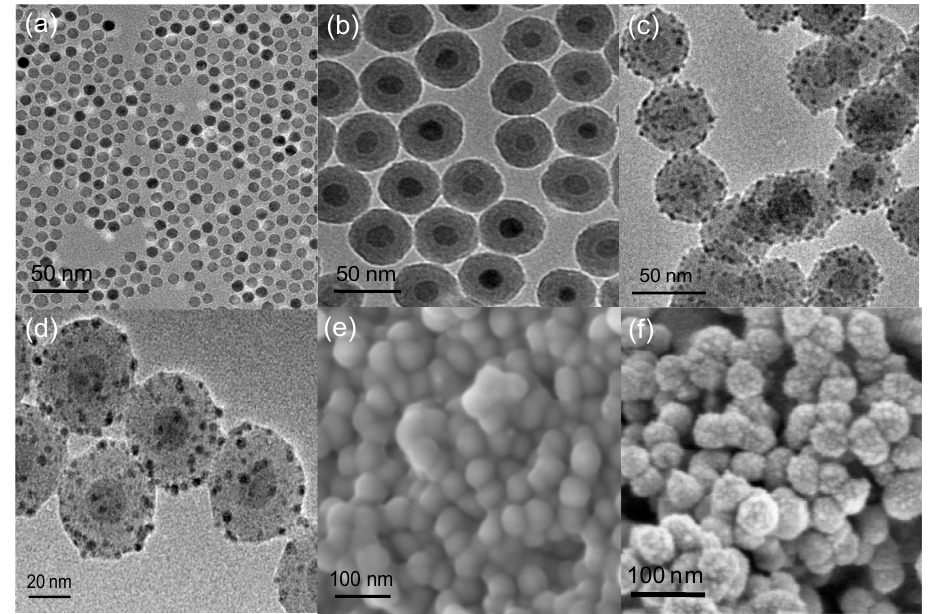
Figure 8. ( a ) TEM image of Fe 3 O 4 NPs; ( b ) TEM image of silica-coated Fe 3 O 4 NPs; ( c ) TEM image of the magnetically-recyclable Pd nanocatalysts; ( d ) HRTEM image of the magnetically-recyclable Pd nanocatalysts; ( e ) FESEM image of silica-coated Fe 3 O 4 NPs; ( f ) FESEM image of the magnetically-recyclable Pd nanocatalysts. Reprinted with permission from